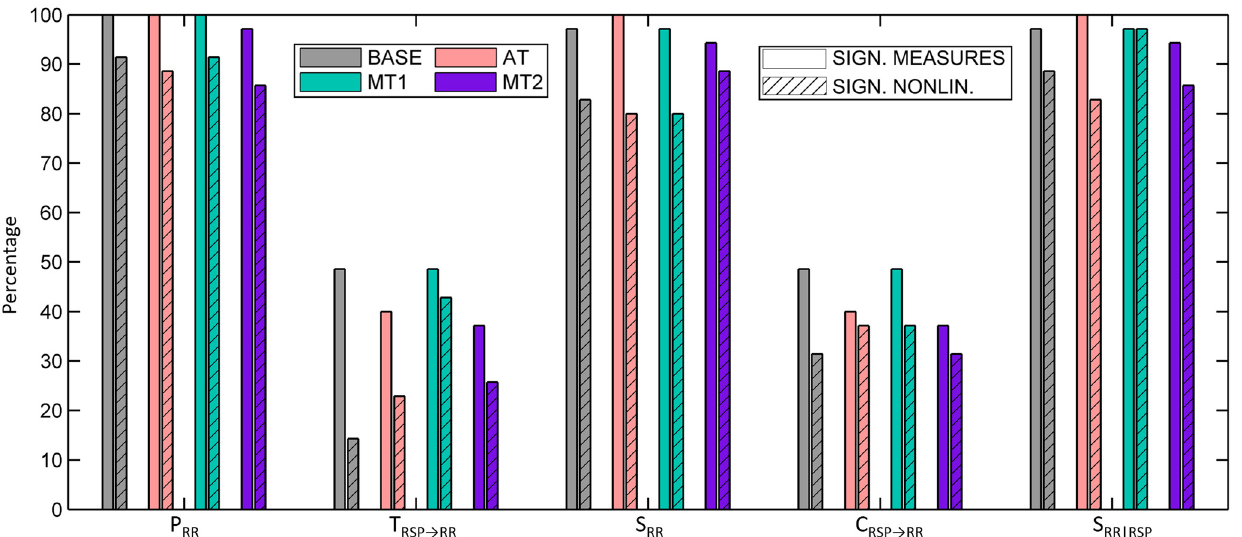
Fig 2. Bar graphs indicating the percentage of significant information-theoretic measures (plain) and the percentage of significant nonlinearities (hatched), during baseline (BASE), sustained attention (AT) and the mental stress tasks (MT1 and MT2).